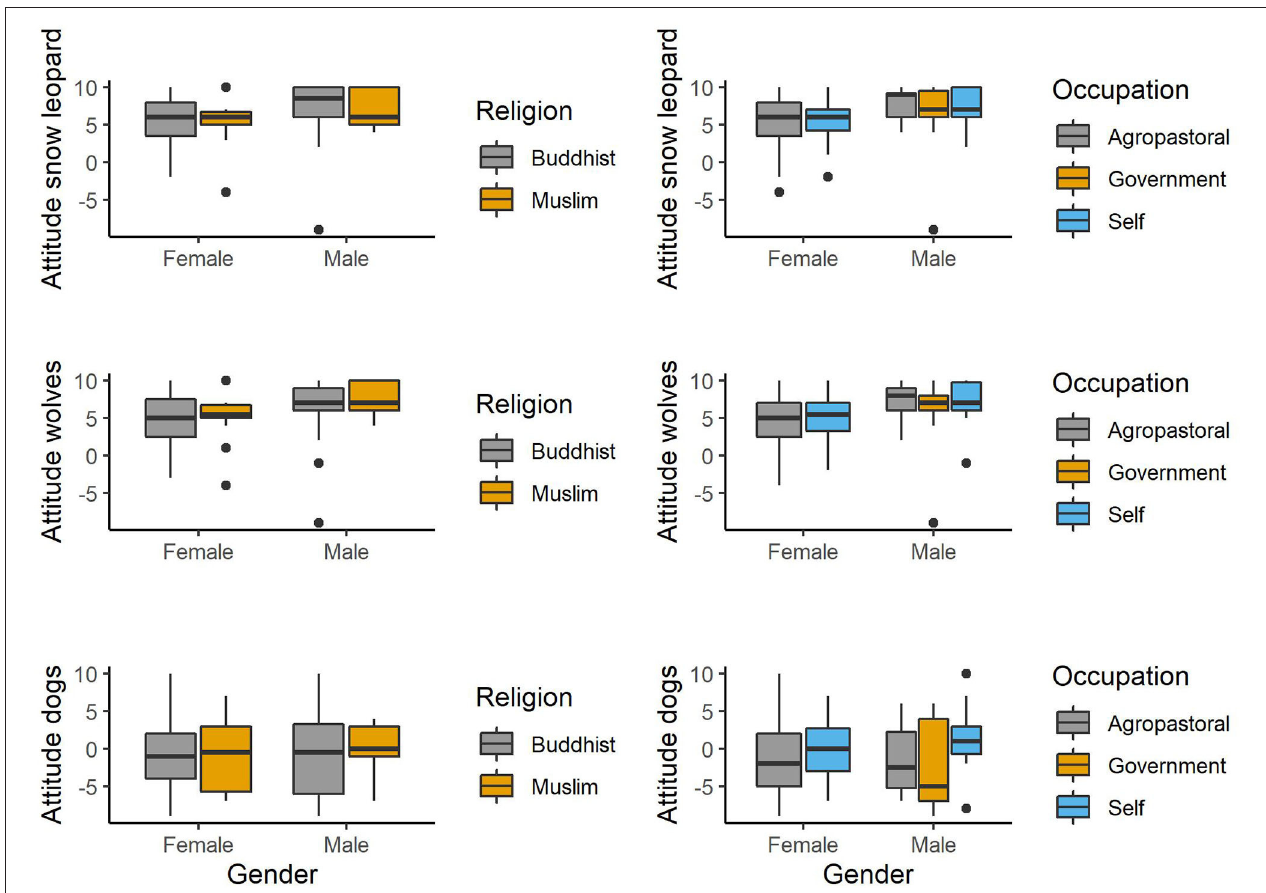
FIGURE 3 | Boxplot showing the relationship between religion and occupation to attitudes of respondents toward snow leopards, wolves, and free ranging dogs. The plot shows minimum, first quartile, median, third quartile, and maximum values of attitudes. Outliers are indicated by dark circles.